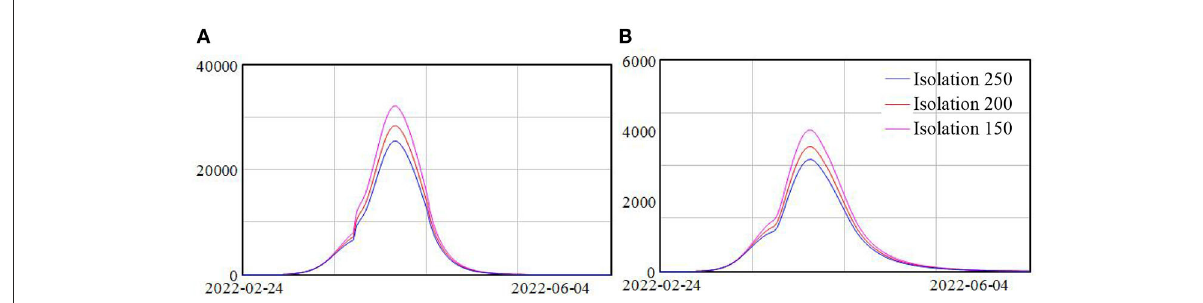
FIGURE4 (A,B) Model scenarios with different isolation policy.